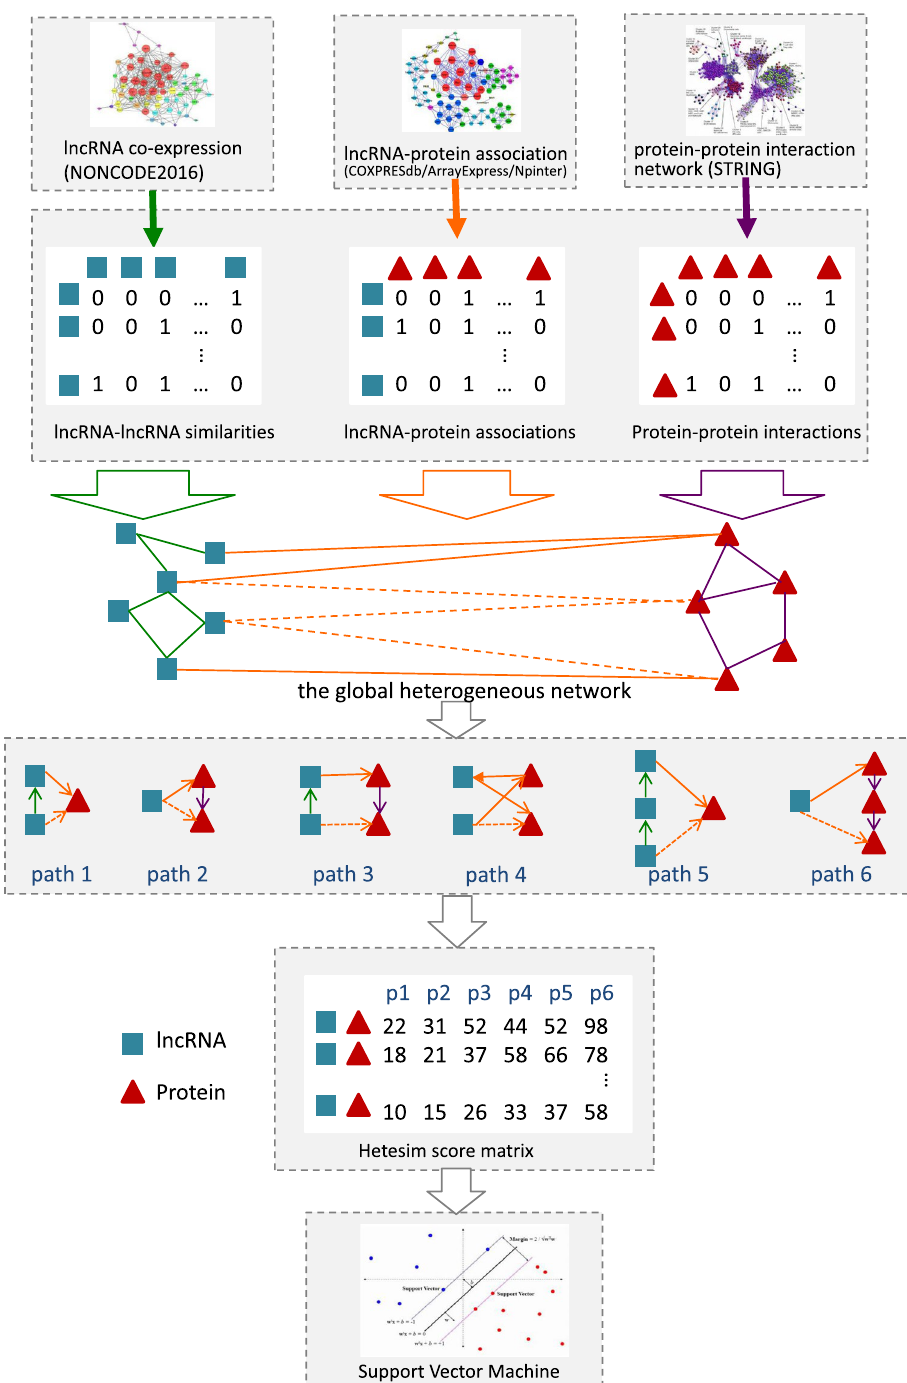
Figure 2. Flowchart of PLPIHS. It includes three steps: (1) constructing a heterogeneous network consisting of a lncRNA-lncRNA similarity network, a lncRNA-protein association network and a protein-protein interaction network; (2) using the HeteSim measure to calculate a score for each lncRNA-protein pair in each path; (3) combining the scores of different paths with a SVM classifier and making